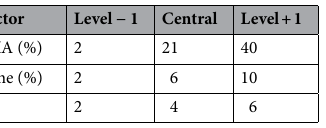
Table 4. Factors and levels of experimental